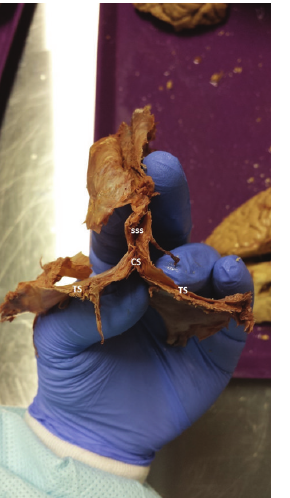
Figure 5: Dura mater with superior sagittal sinus (SSS), two trans- verse sinuses (TS), and confluence of sinus (CS) joining the three sinuses.